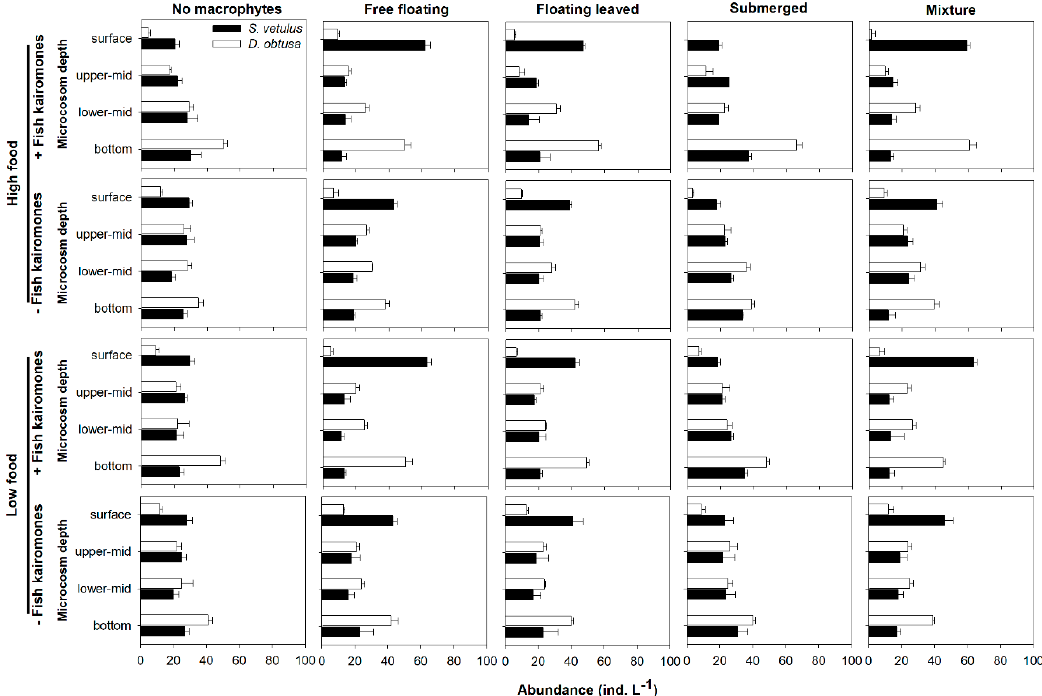
Figure 6. The vertical distribution of Simocephalus vetulus and Daphnia obtusa in the microcosm experiment, in relation to different treatments (macrophyte type, fish presence, and food availability in each of microcosm experiment).